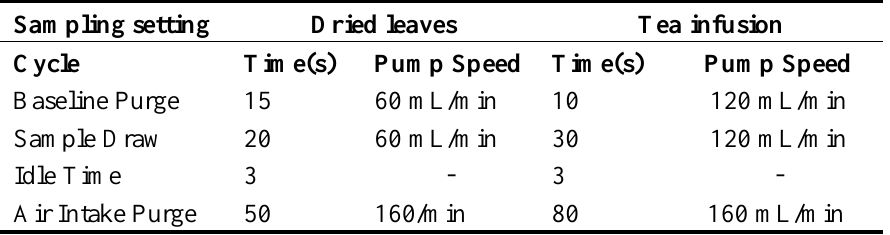
Table 3. E-nose parameter setting for Orthosiphon stamineus tea